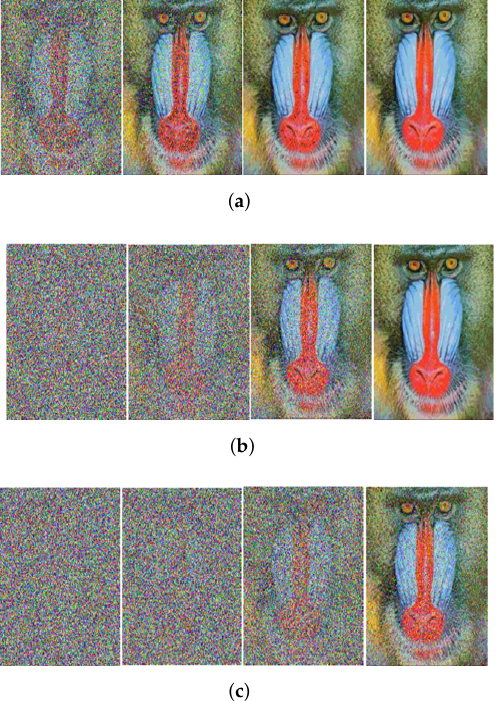
Figure 6. Received image with massive MIMO incorporated FFT-OFDM over a Rayleigh channel, Modulated with 8-PSK and at SNR = 0, 10, 20, 30 dB from Left to Right for different number of users, n . ( a ) n = 10; ( b ) n = 20; ( c ) n = 50.